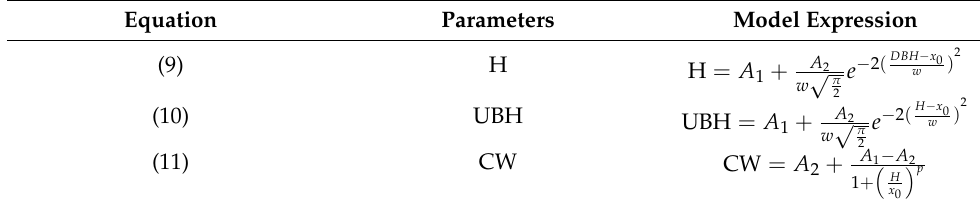
Figure 5. Matrix analysis of morphological structure factors of 1008 center trees. Table 4. Fitting models of Chinese fir tree height, branch height and crown